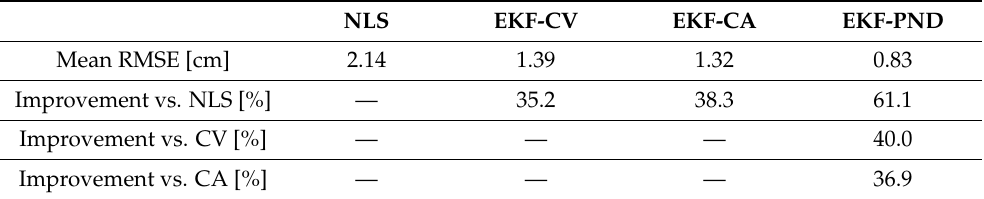
Table 4. Average RMS antenna position errors for NLS, EKF-CV, EKF-CA, and EKF-PND. NLS EKF-CV EKF-CA EKF-PND Mean RMSE [cm] 2.14 1.39 1.32 0.83 Improvement vs. NLS [%] — 35.2 38.3 61.1 Improvement vs. CV [%] — — — 40.0 Improvement vs. CA [%]